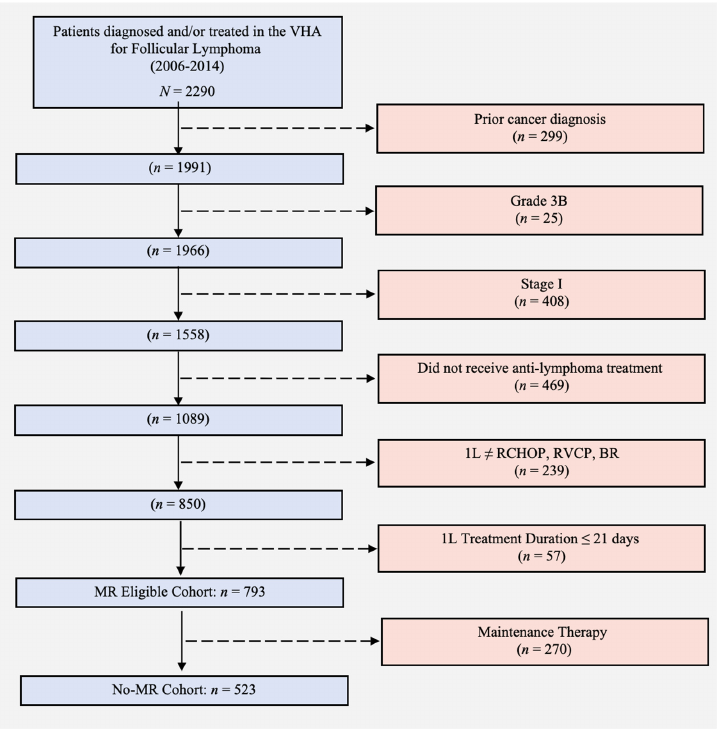
Figure 1. Study cohort attrition. 1L: first-line treatment; BR: bendamustine and rituximab; MR: maintenance rituximab; RCHOP: rituximab, cyclophosphamide, doxorubicin, vincristine, and prednisone; RCVP: rituximab, cyclophosphamide, vincristine, and prednisone; VHA: Veterans Health Administration. The dataset included 523 patients, with 1933 variables. Median follow-up time was 5.03 years, and median survival time 9.32 years. At five years, 150 (28.68%) patients had died, 111 (21.22%) patients had been administratively censored at the end of the study observation period, and 262 (50.10%) patients were alive. Within two years, 99 patients (22.81%) experienced progression of disease (POD24). As in Casulo et al. [15], we excluded from our POD24 analysis 89 patients who were administratively censored ( n = 28) or died ( n = 61) from causes unrelated to their disease relapse, to the best of our knowledge. Figure 2 illustrates cohort distribution for POD24 and reference groups.